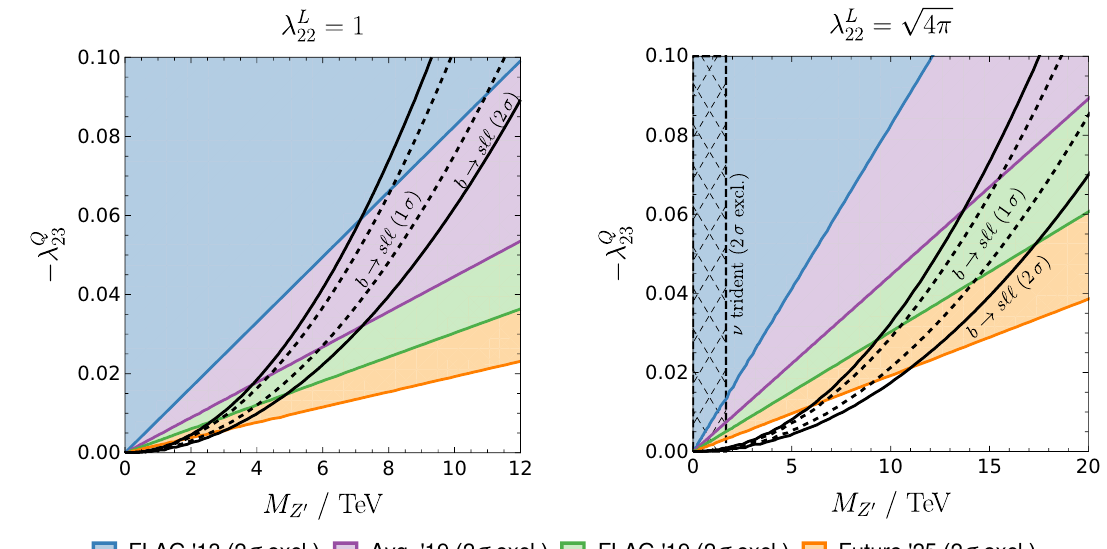
Figure 8 . Parameter space of a naive Z 0 model explaining b ! s‘‘ via real LH currents, for two representative lepton couplings: (cid:21) L from various determinations of (cid:1) M